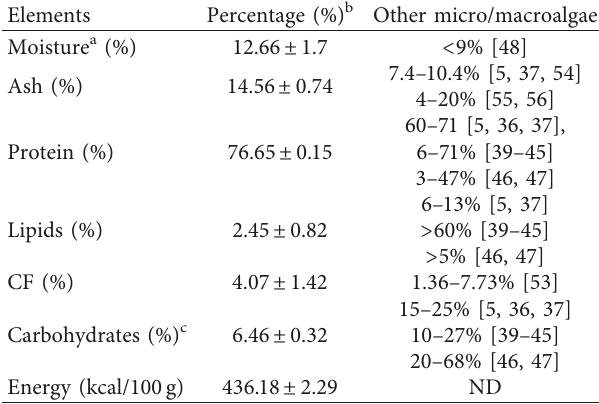
Table 1: Global nutritional analysis of Spirulina (Morocco) (% of dry matter).